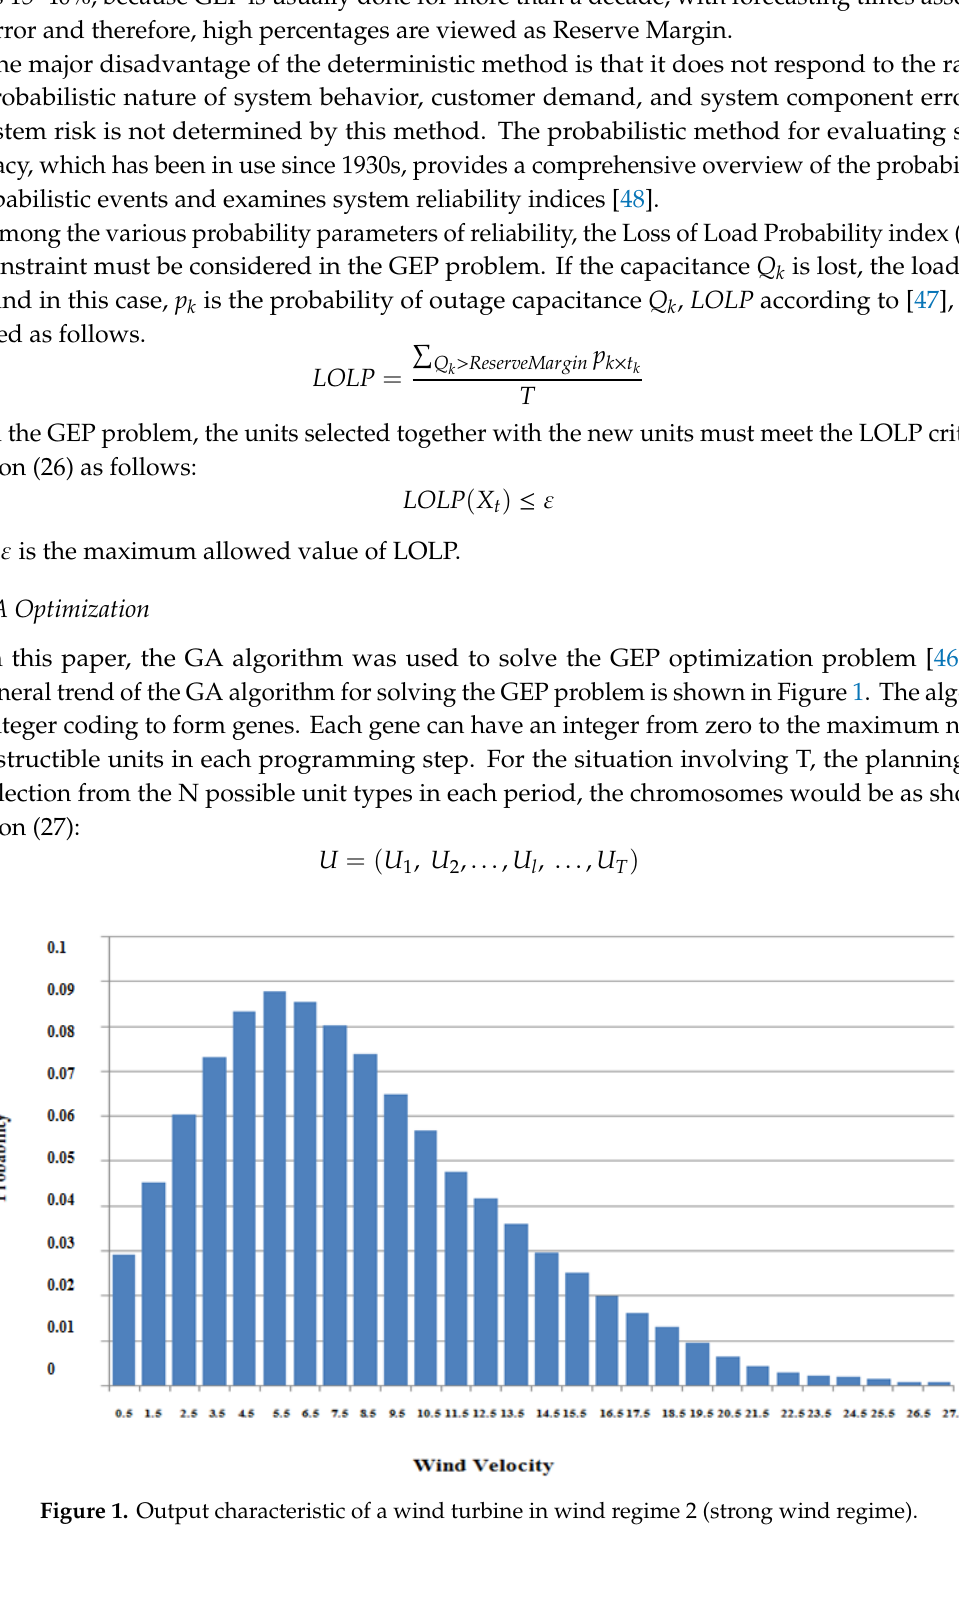
Table 5. Sixty-megawatt wind farm output power model for two wind regimes.